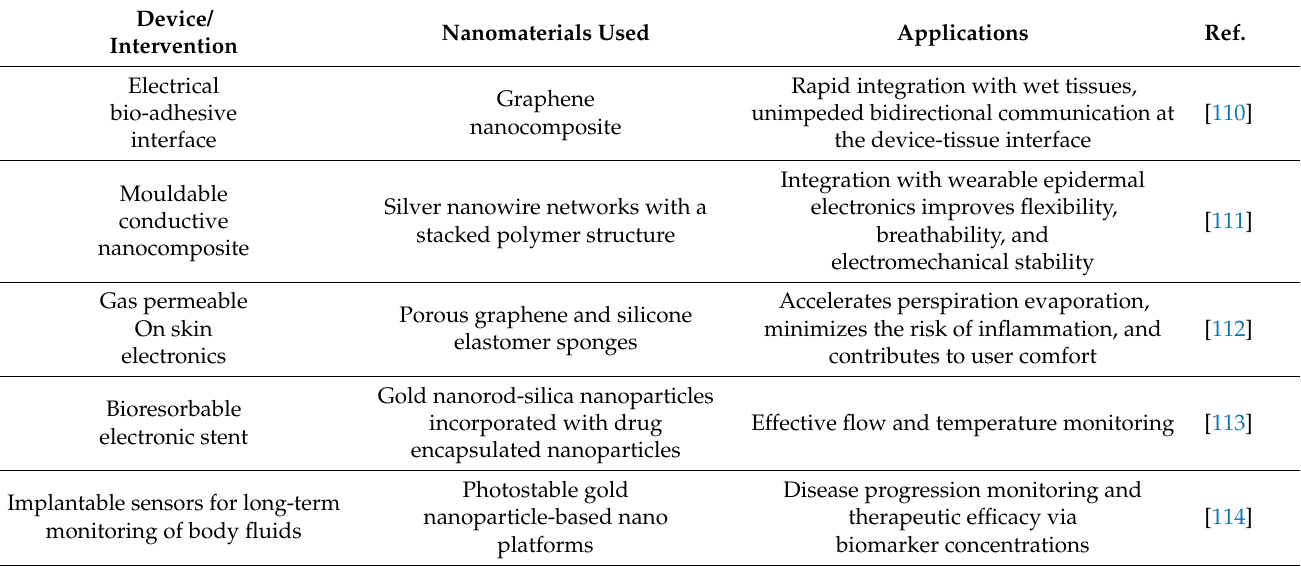
Table 4. Nanotechnology-based advances in smart materials and soft